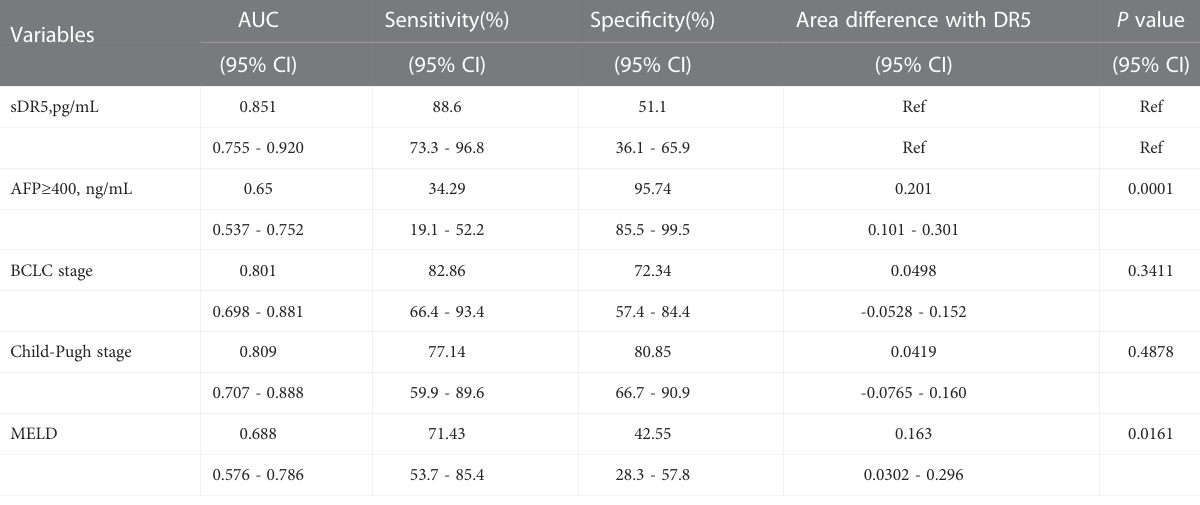
TABLE 4 Predictive value of the DR5, AFP, BCLC stage, Child-pugh stage and MELD score in derivation cohort.